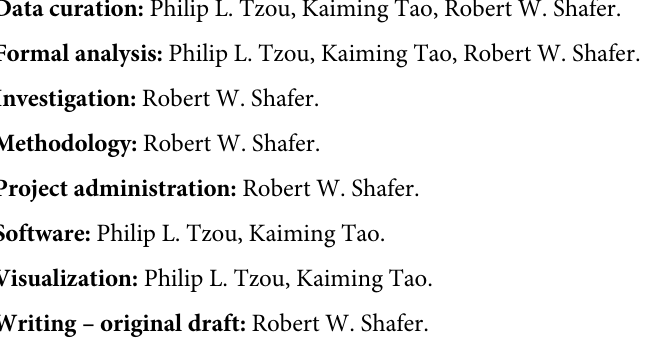
S3 Fig. Functions of the SARS-CoV-2 sequence analysis program. The program supports three types of input: a list of spike mutations; one or more consensus FASTA sequences con- taining any part of the SARS-CoV-2 genome; and one or more FASTQ sequences. However, because a FASTQ sequence can take several minutes to analyze, users are advised to first con- vert them to a codon frequency (CodFreq) file through an auxiliary program. If a list of spike mutations is submitted, the program returns comments about notable mutations and sum- mary tables reporting the susceptibility of viruses with these mutations to mAbs, CP, and VP. If a FASTA sequence is submitted, the program returns the preceding information plus a list of the SARS-CoV-2 genes, the amino acid mutations in the sequence, and the sequence’s PANGO lineage. If a FASTQ sequence or codon frequency table is submitted, the program provides the preceding information and the read coverage for each position along the genome. It also provides users with the options to select read depth and mutation-detection thresholds below which mutations will not be